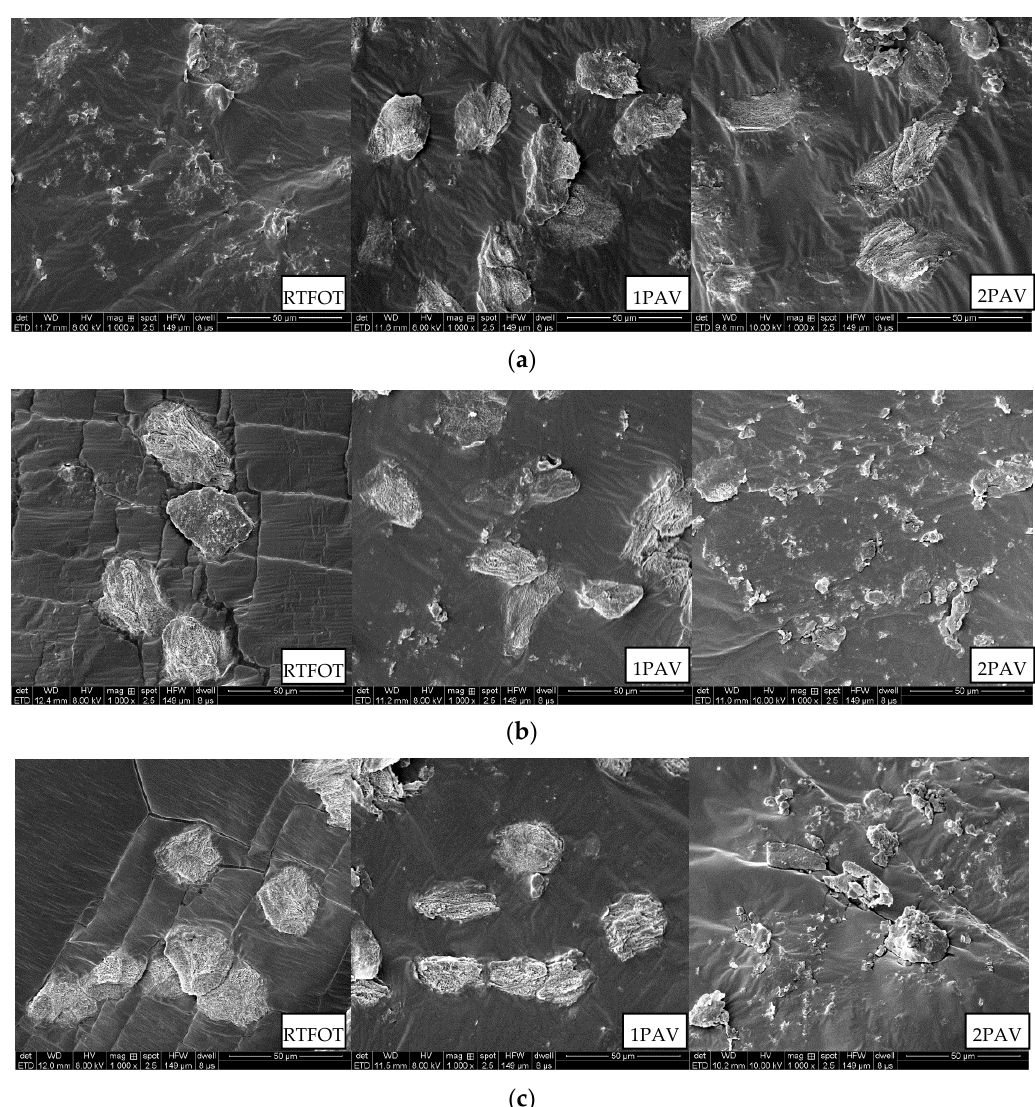
ff erent aging levels. ( a ) 1#; ( b ) 2#; ( c )